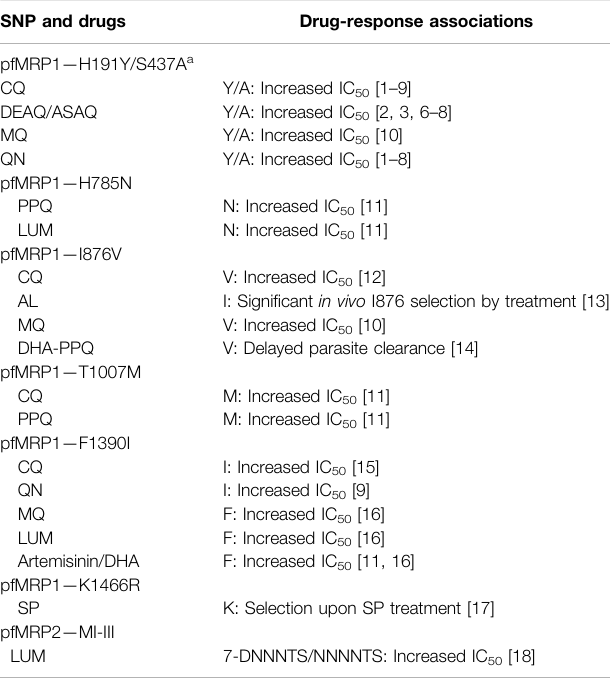
TABLE 1 | pf MRP Sequence variation associated with P. falciparum antimalarial response. SNP and